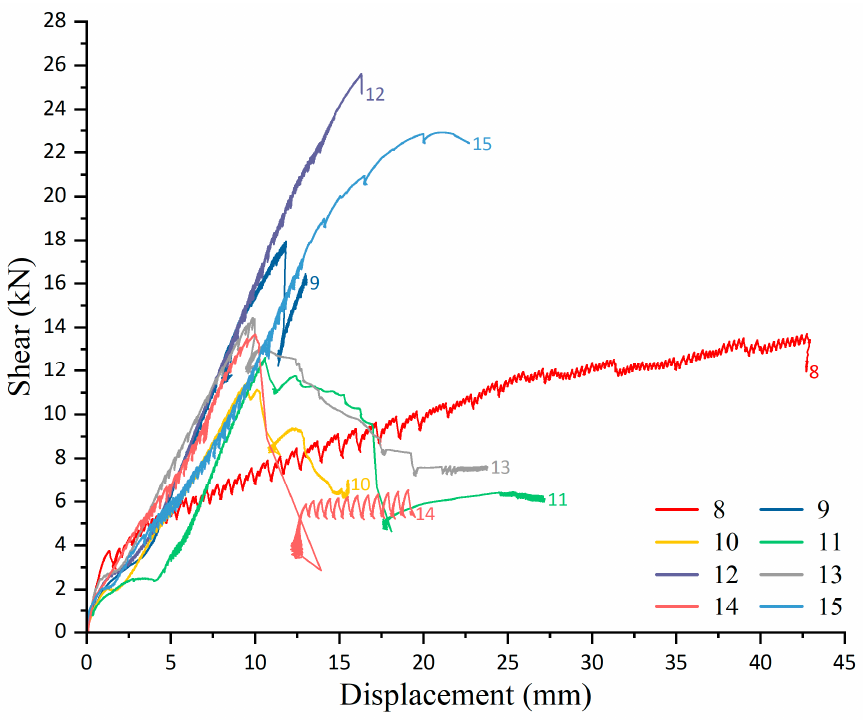
Figure 17. Shear performance of eight associated specimens.